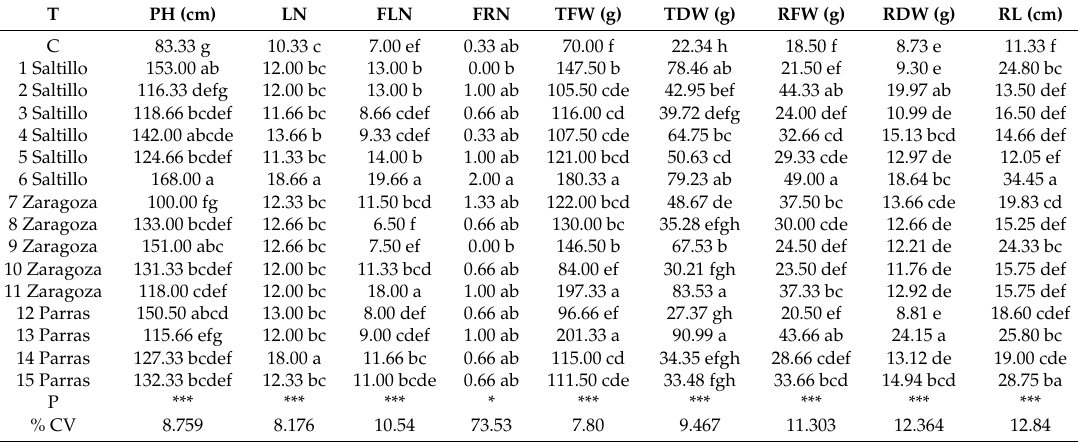
Table 6. Average effects (Tukey, p ≤ 0.05) of AMF on the agronomic parameters of greenhouse-grown melon. The letter in the table is the result of the Tukey comparison